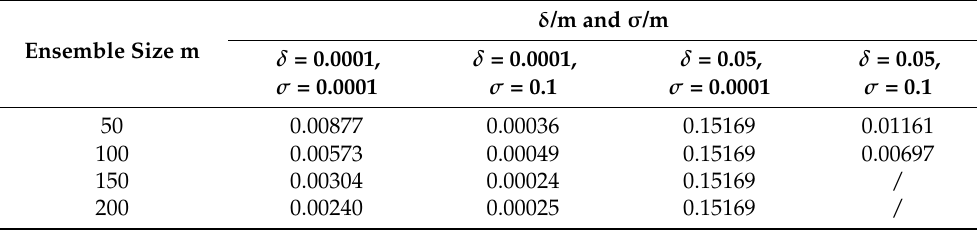
Table 3. RMSE values with different ensemble sizes at fixed δ and σ values for Station 1.